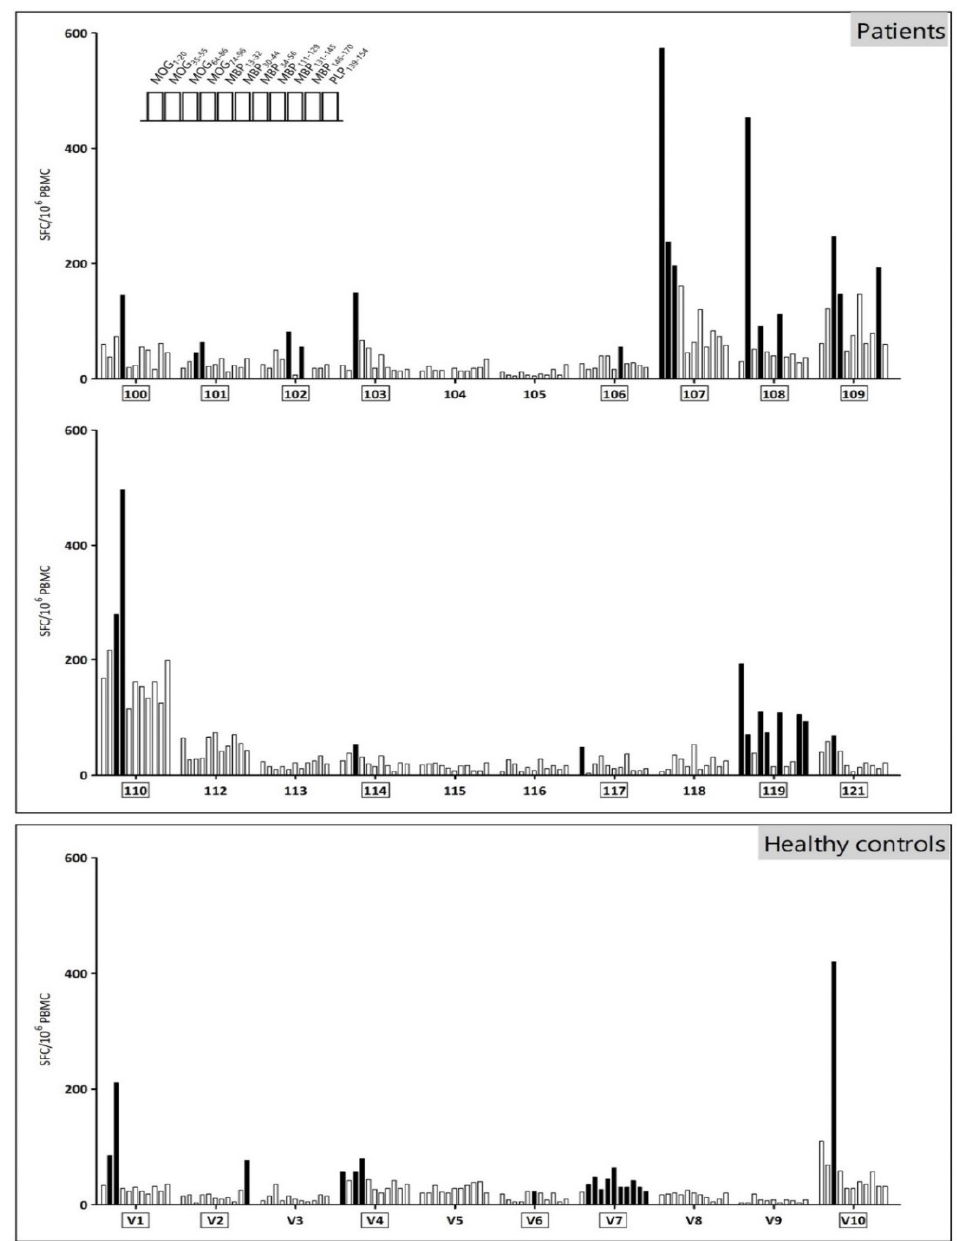
Figure 1. Myelin reactivity screening in 10 healthy controls and 20 MS patients, untreated or treated with first-line immunomodulatory therapy. Per patient or healthy control, each bar represents the IFN-γ response towards the different peptides in the following order: MOG 1–20 -MOG 35–55 -MOG 64–86 - MOG 74–96 -MBP 13–32 -MBP 34–56 -MBP 111–129 -MBP 146–170 -MBP 30–44 -MBP 131–145 -PLP 139–154 . Black bars indicate a positive peptide response, defined as present when >50% of the peptide-restimulated wells were positive. A well was defined as positive when the number of spot-forming cells in the well was higher than the [mean spot forming cells + 3 standard deviations (S.D.)] of the negative control wells. Responder subjects are denoted by a box around the subject code; a responder was defined as a subject demonstrating at least one positive myelin peptide response. Abbreviations used: SFC, spot forming cells; PBMC, peripheral blood mononuclear cells; MOG, myelin oligodendrocyte glycoprotein; MBP, myelin basic protein; PLP, proteolipid protein.